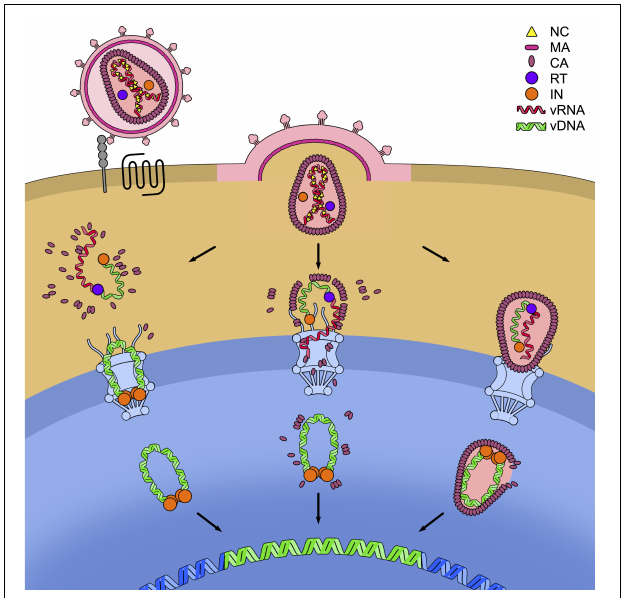
FIGURE 4 | Models for the timing of uncoating. HIV-1 enters the cell after recognition by the envelope glycoproteins of the cellular receptor CD4 (in gray) and the cellular co-receptor CXC4 or CCR5 (in black). This leads to the fusion of the cell and viral membranes and to the release of the capsid core in the cytoplasm. In the figure, the three models of uncoating covered in this review are depicted: the cytoplasmic uncoating (on the left), the uncoating at the nuclear pore complex (NPC) (in the center), and the nuclear uncoating (on the right). In each model the reverse transcription of the viral genomic RNA (vRNA) (in red) into viral DNA (vDNA) (in green) has to be completed, allowing its integration in the host genome (in blue). The reverse transcription complex (RTC) is schematically shown as the association of a molecule of reverse transcriptase (RT, in purple) to the vRNA and single-stranded vDNA. The completed vDNA forms the pre-integration complex (PIC), shown as the double-stranded vDNA bound to a tetramer of integrase (IN, in